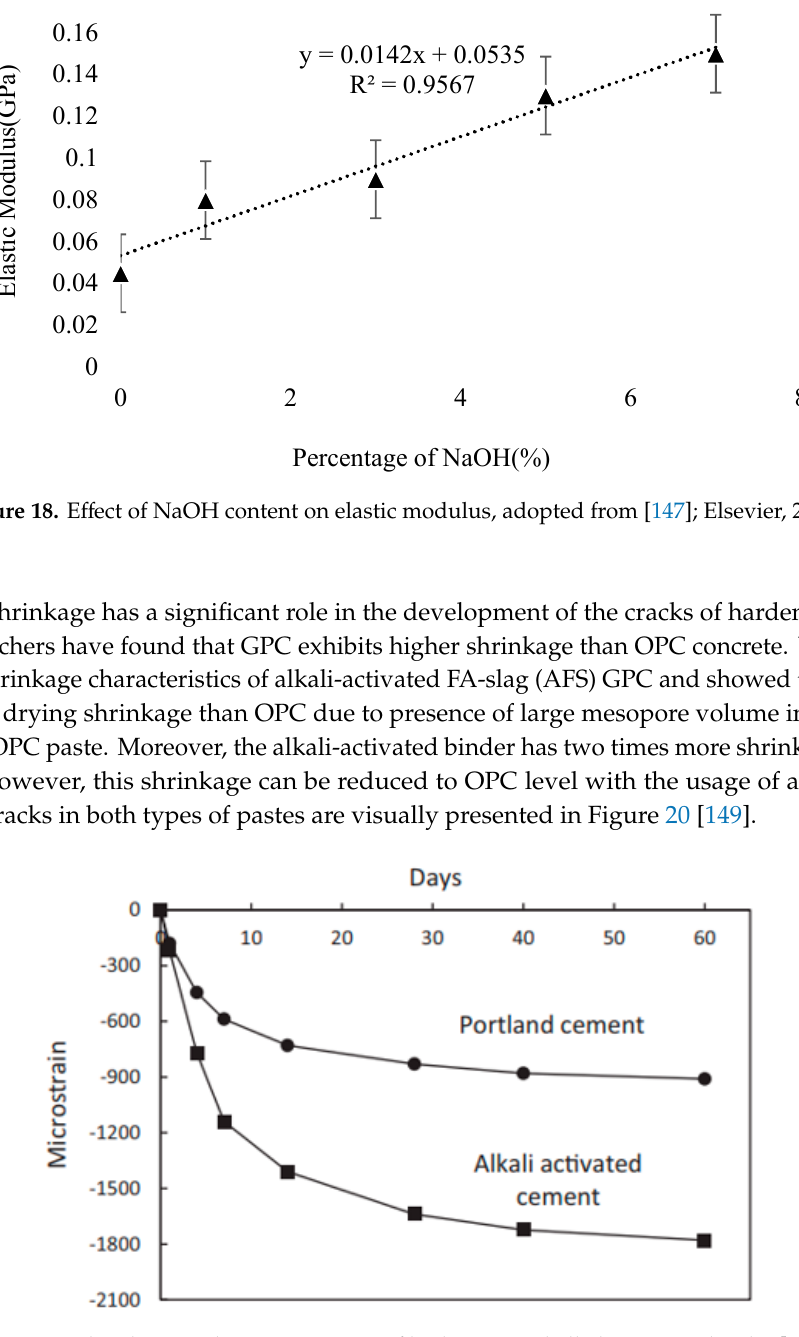
Figure 20. SEM image of ( a ) OPC paste and ( b ) alkali activated binder paste [149].